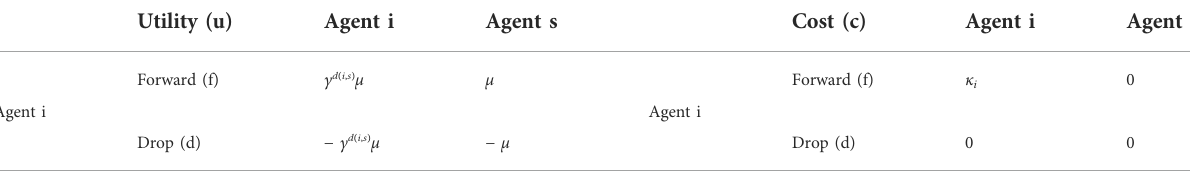
TABLE 4 Utilities and Costs for intermediary agent (i) and source agent (s) as a result of decisions taken by